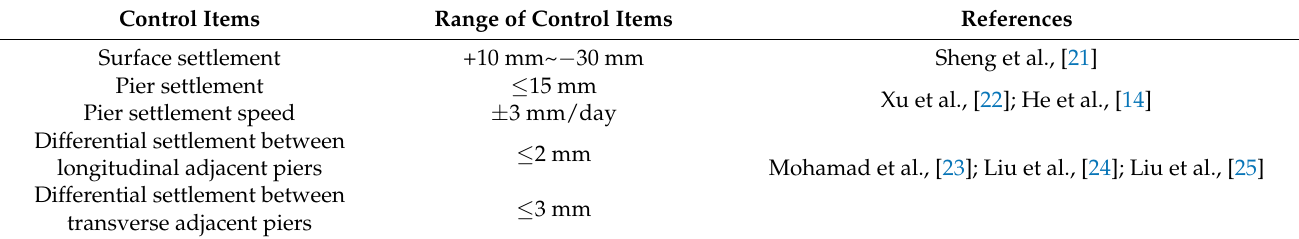
Table 1. Deformation control